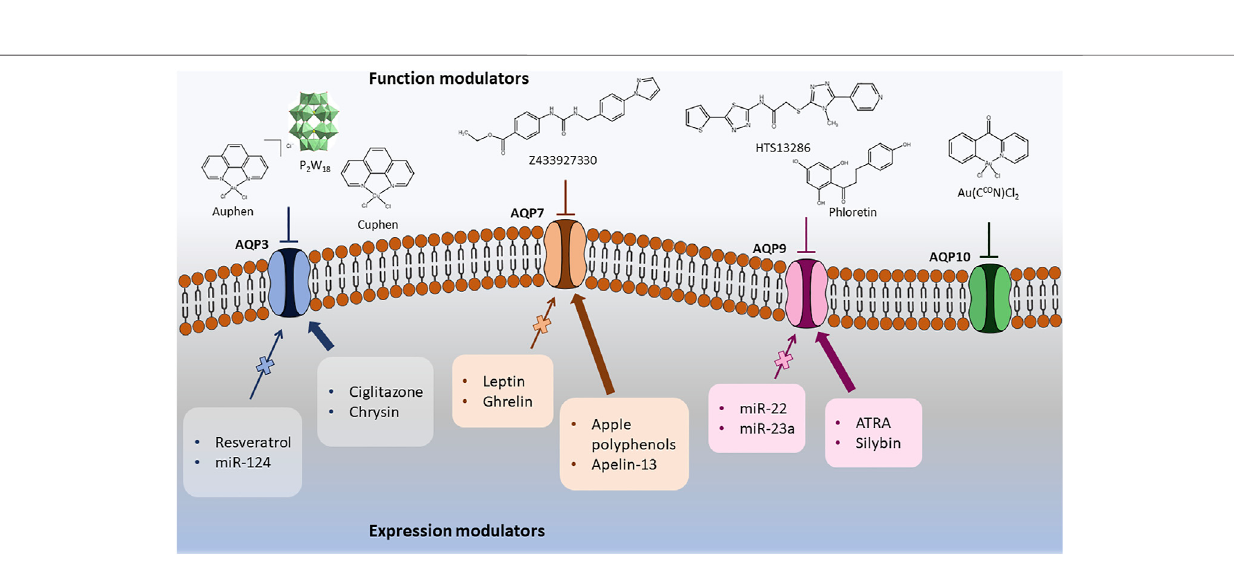
FIGURE 4 | Representative compounds modulators of aquaglyceroporin function or